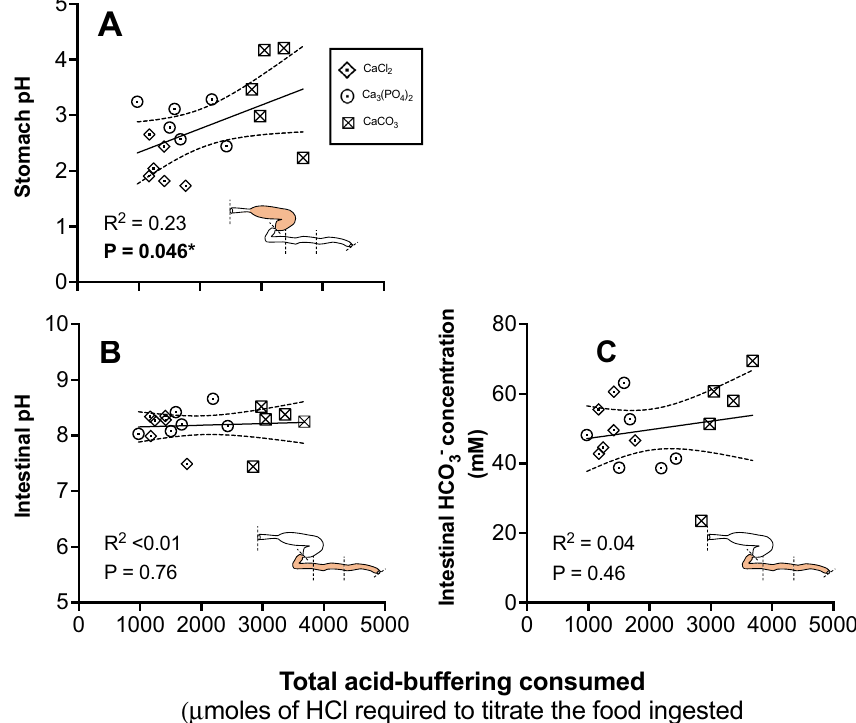
Figure 1. Change in stomach pH ( A ), intestinal pH ( B ) and intestinal HCO 3 − concentration ( C ) of juvenile rainbow trout ( Oncorhynchus mykiss ) 48 h after consuming a 2.5% ration of one of three experimental feeds (n = 6 for the CaCl 2 and Ca 3 (PO 4 ) treatments; n = 5 for CaCO 3 treatment) of varying buffer capacity. The ranked order (and relative magnitude) of the dietary acid-buffering capacity of each diet was CaCO 3 > Ca 3 (PO 4 ) 2 > CaCl 2 (2.4 > 1.4 > 1). Solid line represents the regression line while the dotted line represents the 95% confidence interval (CI). Significance was accepted at P < 0.05 following a simple linear regression. Each data point represents values from